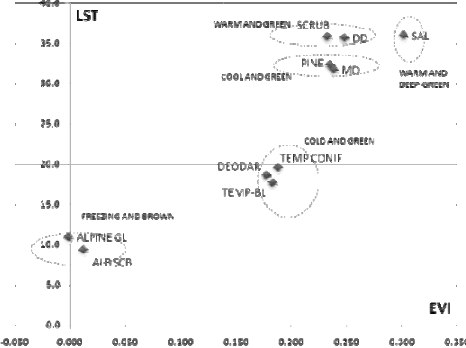
Fig.2. Distribution of Vegetatio